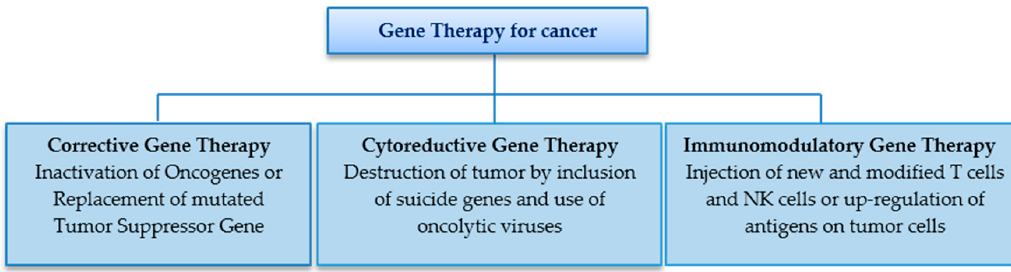
Figure 4. Various strategies and types of gene therapy approaches used for cancer treatment.